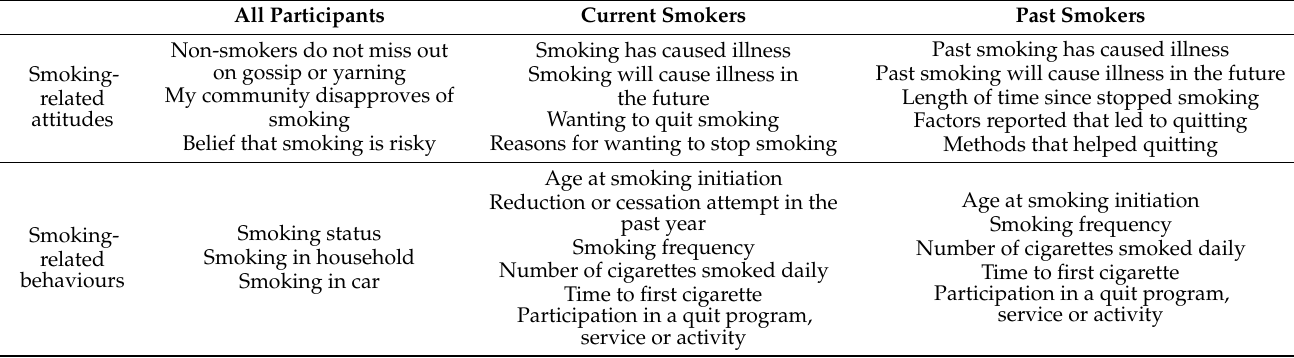
Table 1. Mayi Kuwayu Study smoking-related variables used in the current